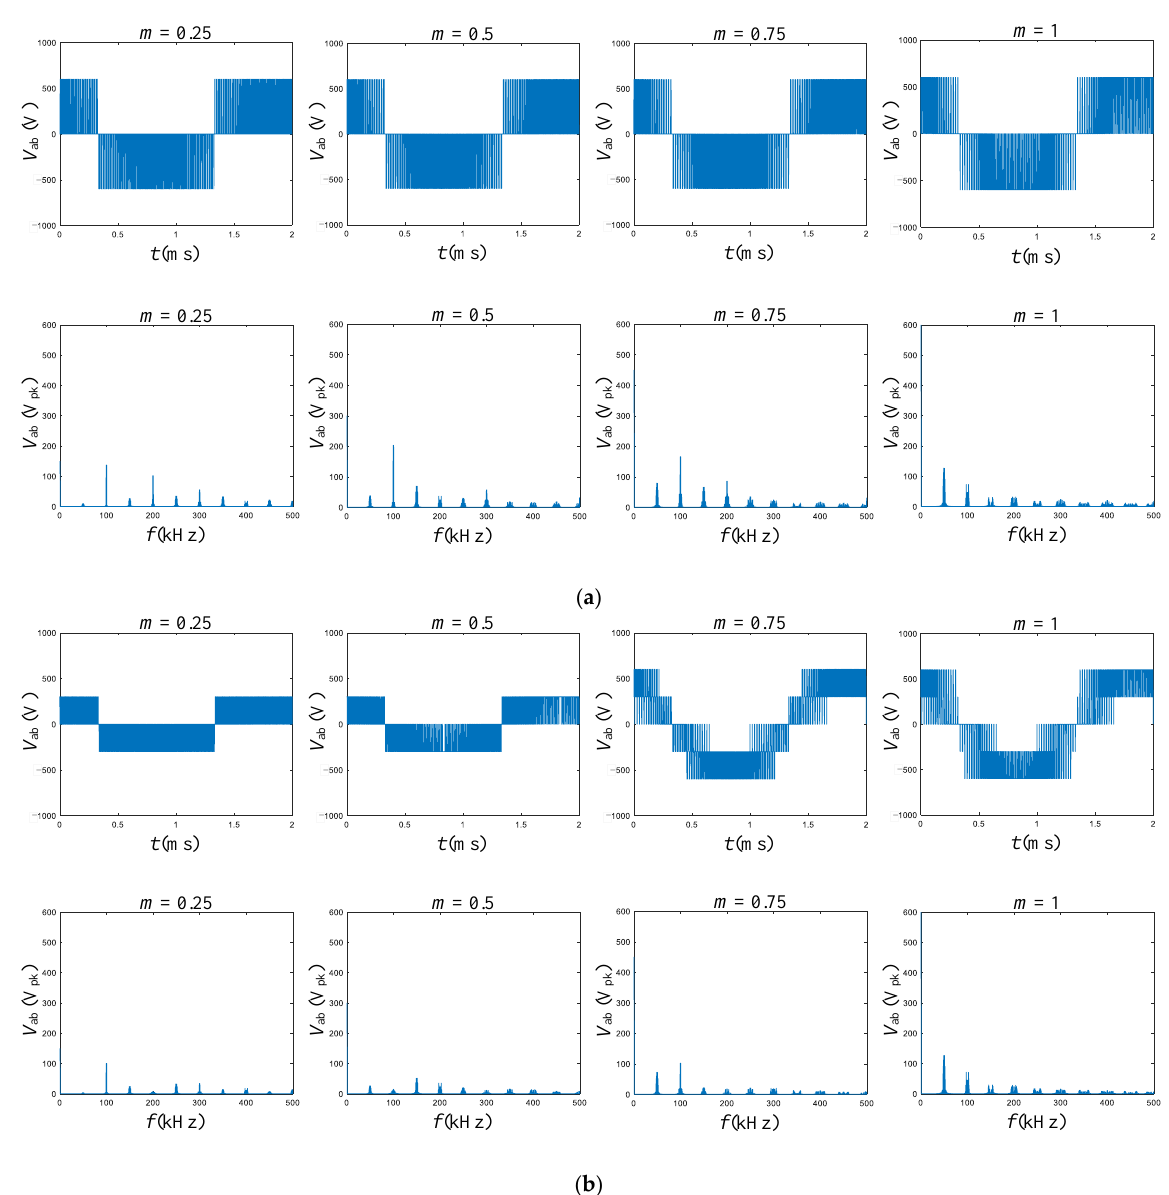
Figure 7. Time-domain and frequency-domain plots of the motor line-to-line voltage in EV 2 under four different modulation index values. ( a ) Design A. ( b ) Design B.